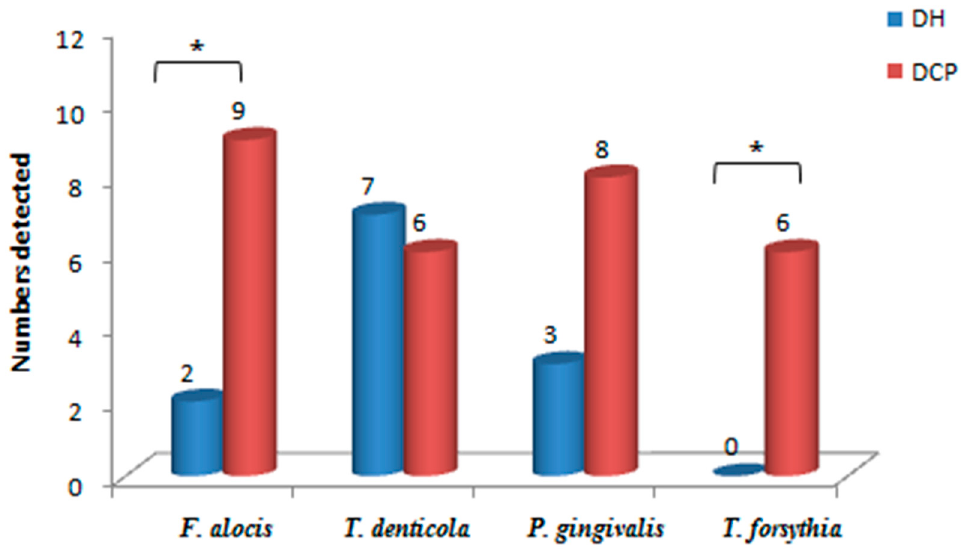
Figure 2. Occurrence of F. alocis and red complex organisms in the DH and DCP groups. * p < 0.05 = significant. Table 3. Occurrence of red complex bacteria in the presence or absence of F. alocis .